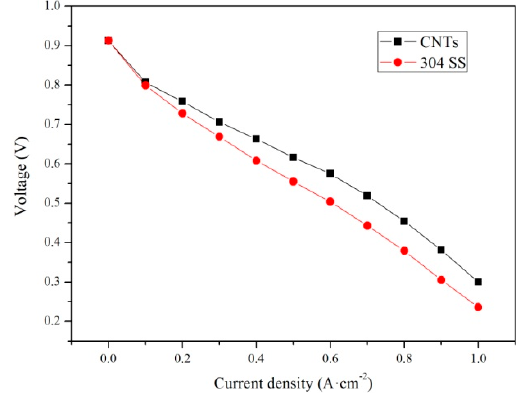
Figure 12. Initial performance of the two cells: Bare 304 SS as the bipolar plate; 304 SS with vertical CNTs as the bipolar plate.